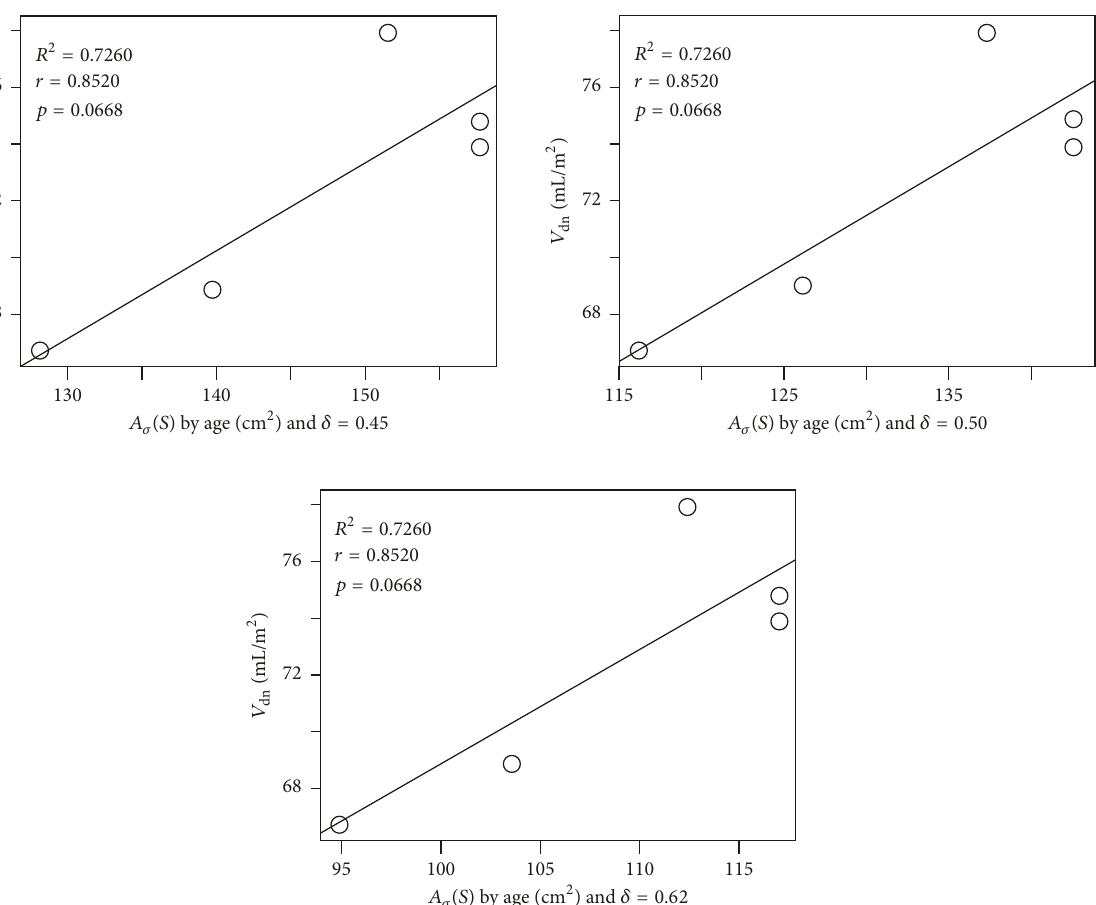
Figure 6: Dispersion and linear regression between the average surface area of LV and the end-diastolic volume normalized by the body area of men per age